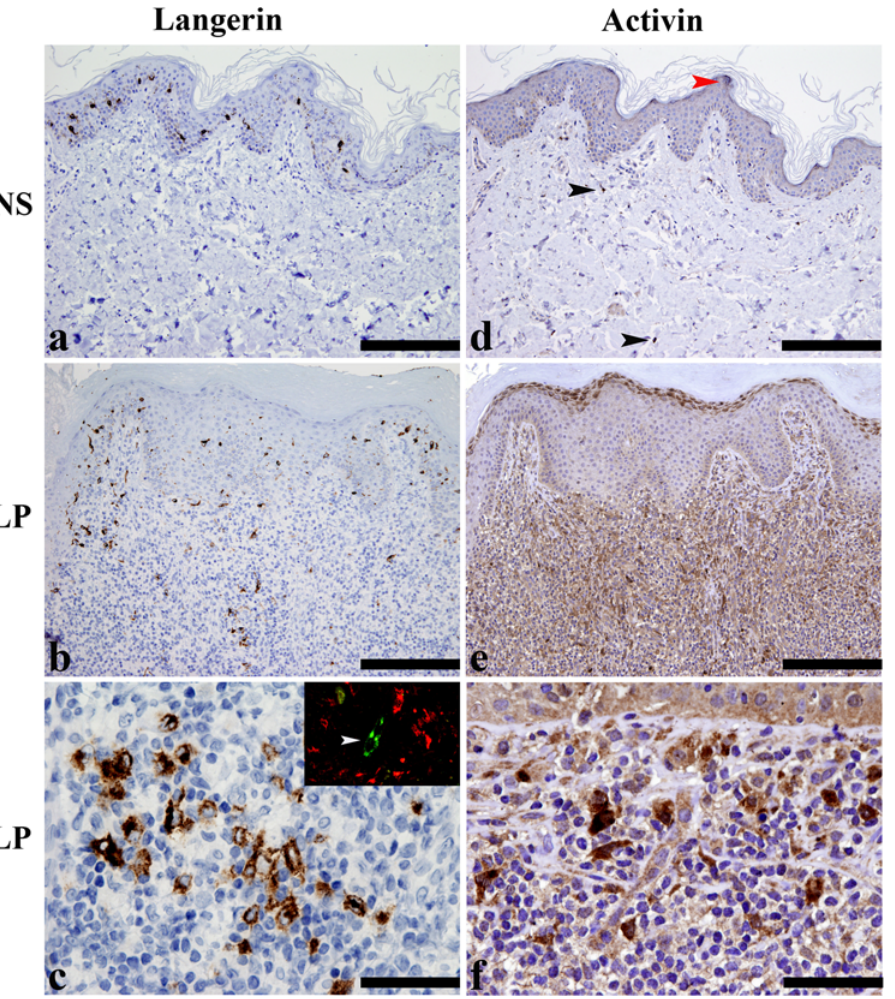
Figure 5. Dermal accumulation of Langerhans cells in lichen planus is associated to abundant production of Activin A. Sections from normal skin (NS) ( a and d ) and lichen planus (LP) ( b, c, e, f ) biopsies were stained for Langerin ( a – c ) and Activin A ( d–f ). In normal skin, Langerin + cells are regularly distributed in basal and suprabasal layers and show multiple fine dendrites; no positive cells are detectable in the dermis (panel a ). In LP biopsies, in addition to intraepidermal LC, accumulation of Langerin + cells is observed in the dermis within the dense monuclear cell infiltrate (panel b ). At high power view, Langerin + cells show an ovoidal/dendritic shape (panel c ) and are found surrounding Factor VIII + dermal blood vessels (arrow head, inset in c ). Serial sections from the same tissue blocks were stained for Activin A. Normal skin (panel d ) showed weak intraepithelial reactivity (red arrow head); in the dermis, mast cells and occasional spindle cells were positive for Activin A (black arrow heads). In LP, Activin A was strongly induced in the superficial layers of epidermis; in the dermis, a diffuse reactivity can be observed in numerous cells within the inflammatory infiltrate (panel e ). This cell population includes endothelial cells and a mixture of non-lymphoid mononuclear cells (panel f ). Magnification 100x ( a, b, d, e ; scale bar 200 micron) and 400x ( c, f ; scale bar 50